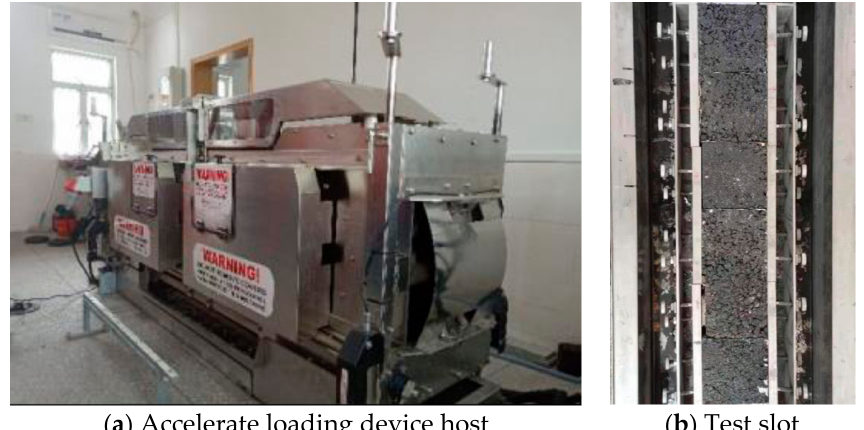
Figure 2. Accelerated loading test